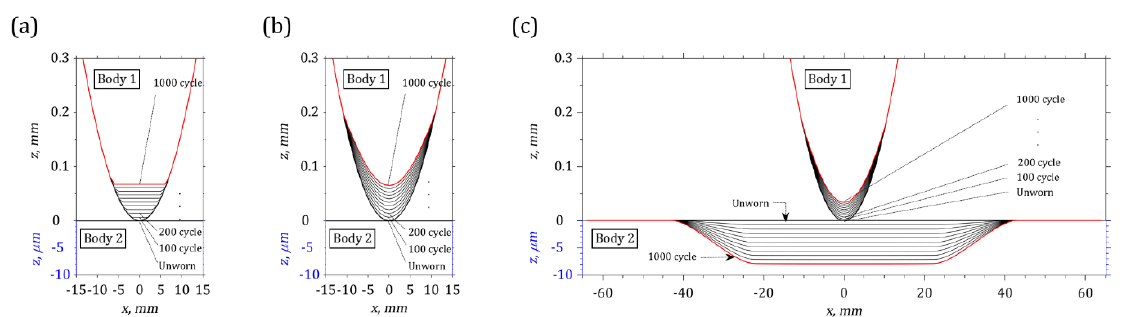
Figure 4. Wear profile for sliding wear of a single asperity with an equivalent elastic modulus of 𝐸 ′ = 110 GPa , Poisson’s ratio 𝜈 = 0.3 , and an equivalent radius of 𝑅 ′ = 300 mm under a normal load of 410 kN: ( a ) Truncation model; ( b ) deterministic fixed model; ( c ) deterministic quasi-static model